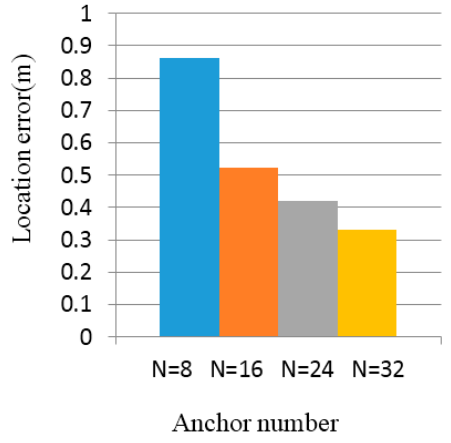
Figure 17. Location error when intensity value is fluctuation 10%.